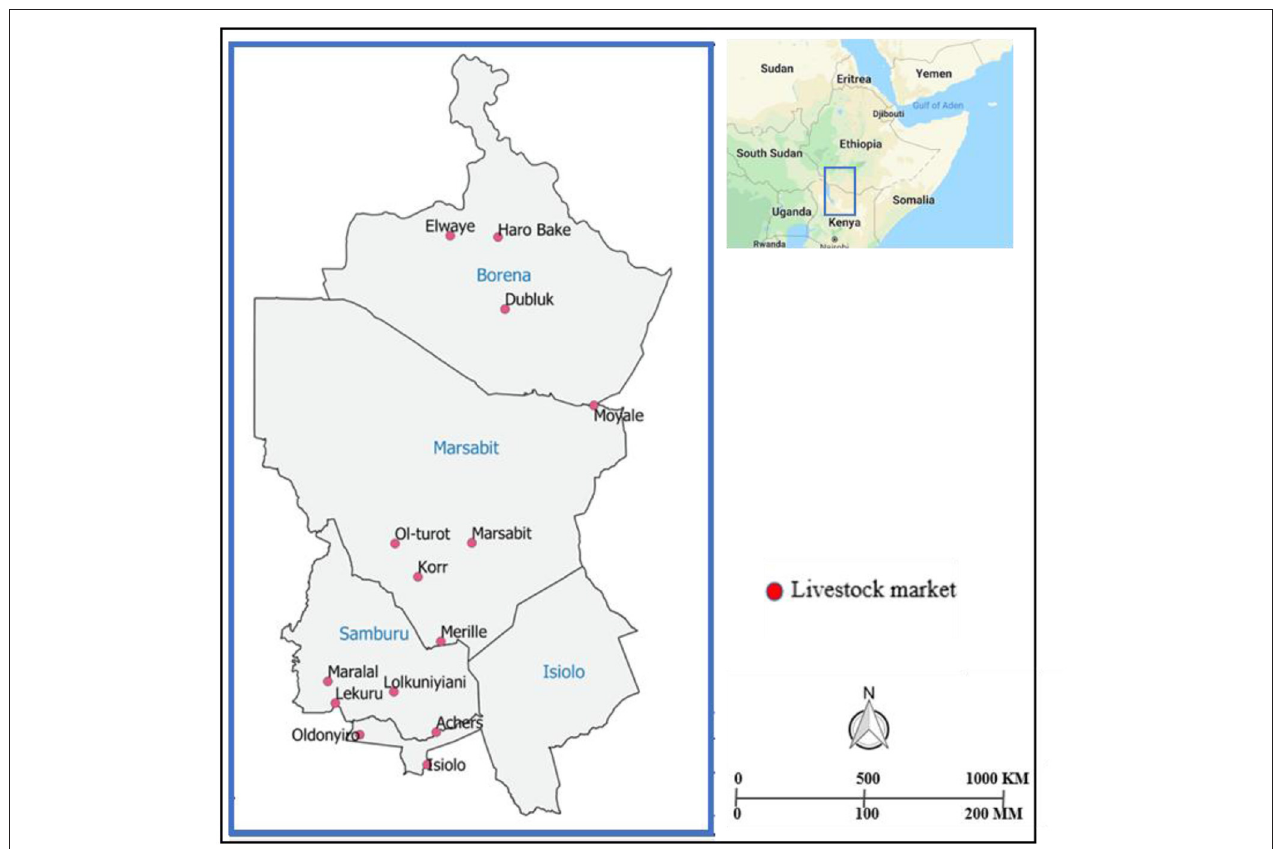
FIGURE 5 | Sampled livestock markets in pastoral drylands of Kenya and